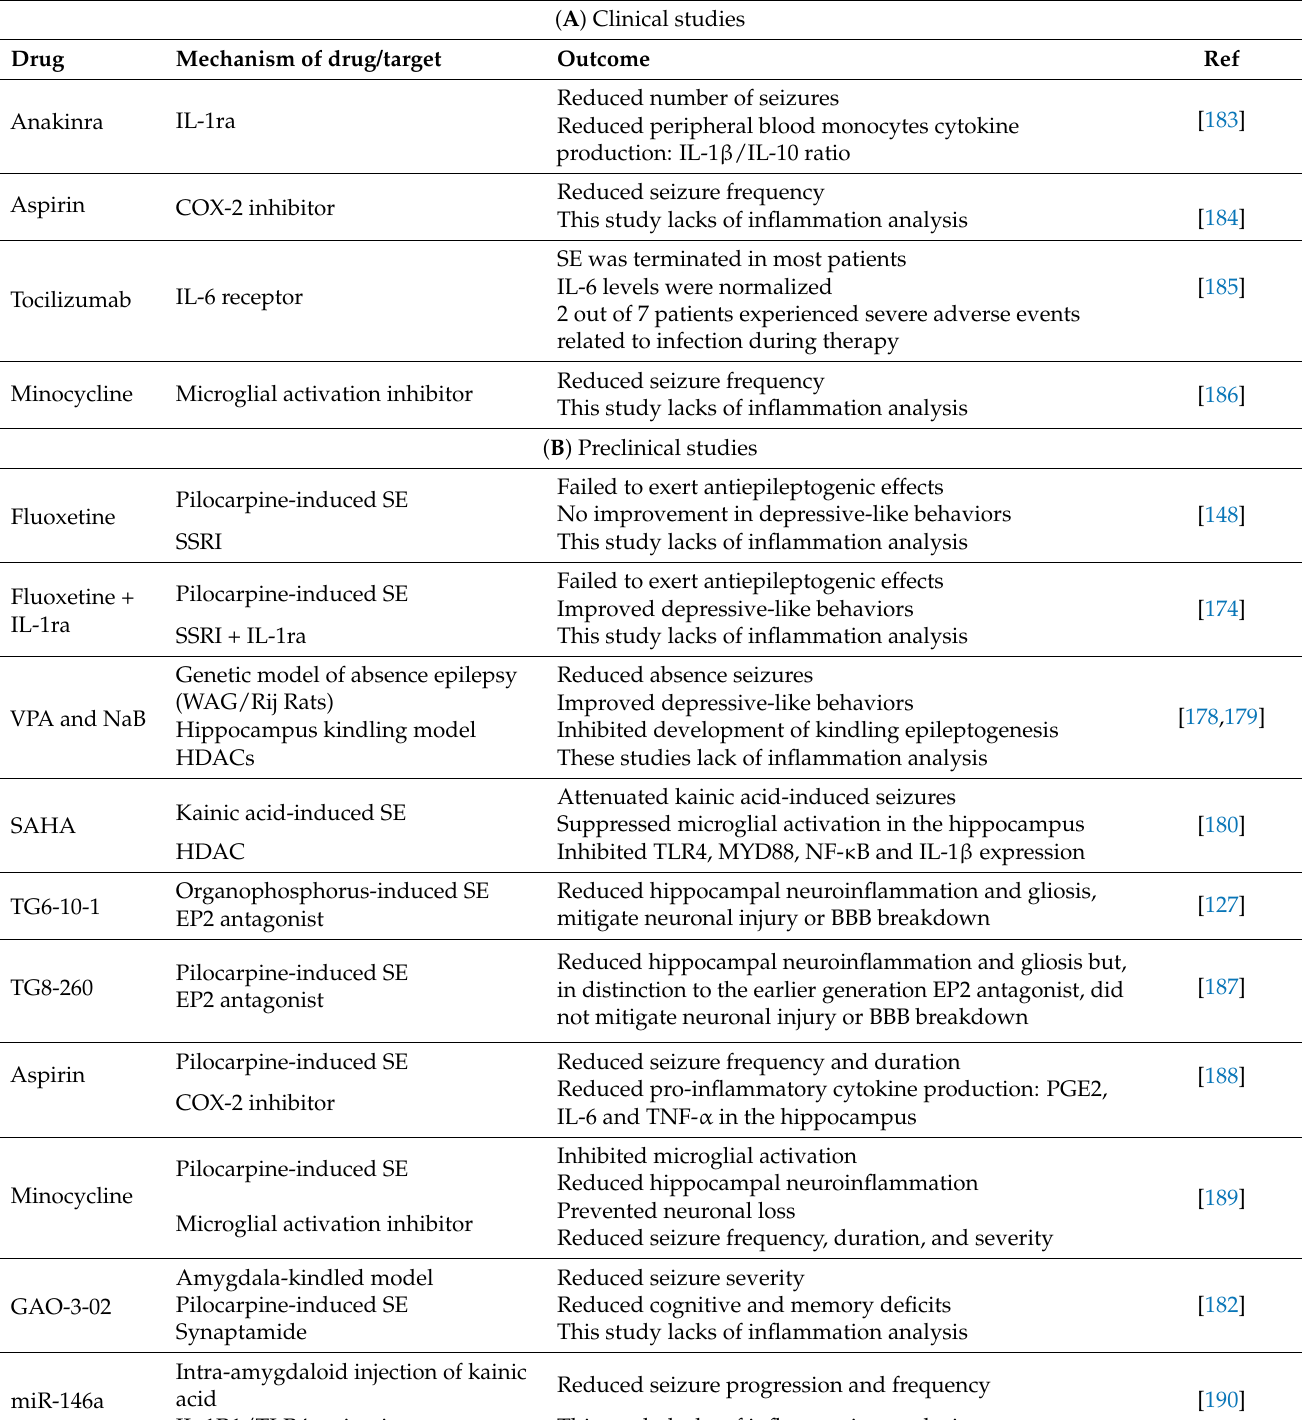
Table 1. Overview of studies targeting neuroinflammation to treat epilepsy and comorbid